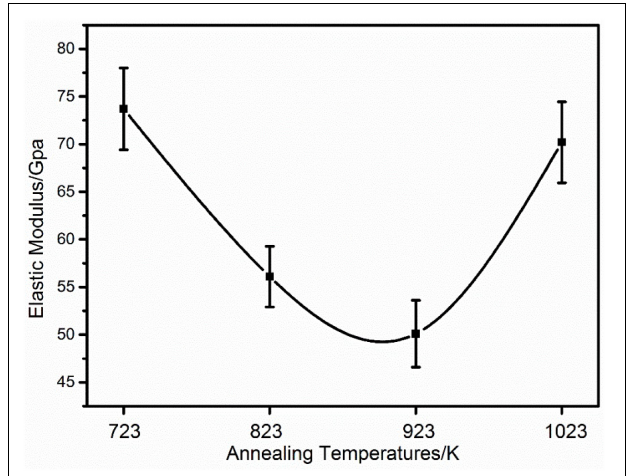
FIGURE 8 | Elastic modulus of the samples at different annealing temperatures.